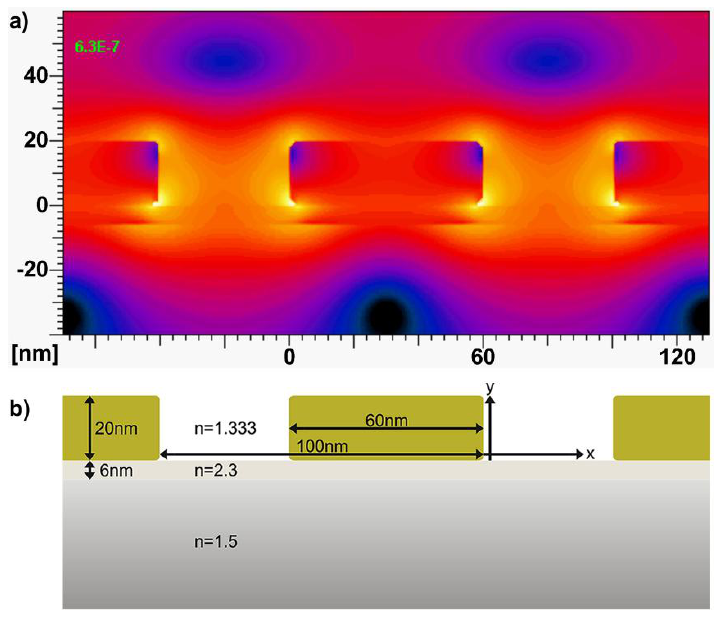
Figure 6. (a) A sample of the simulated time-averaged electric field distribution for the cross-section of a nanowire array at the resonance wavelength of 633 nm in water. Such simulations approximate well the field strength, the field decay length and resonance response to compare and to confirm bulk sensitivities with the measured results. The electric field is especially concentrated at the corners of the wires and extends notably into Nb O the substrate. All nanowire cross-sectional dimensions and refractive indices are 2 5 noted in (b) . The Cr layer between Nb O and Au has been 2 5